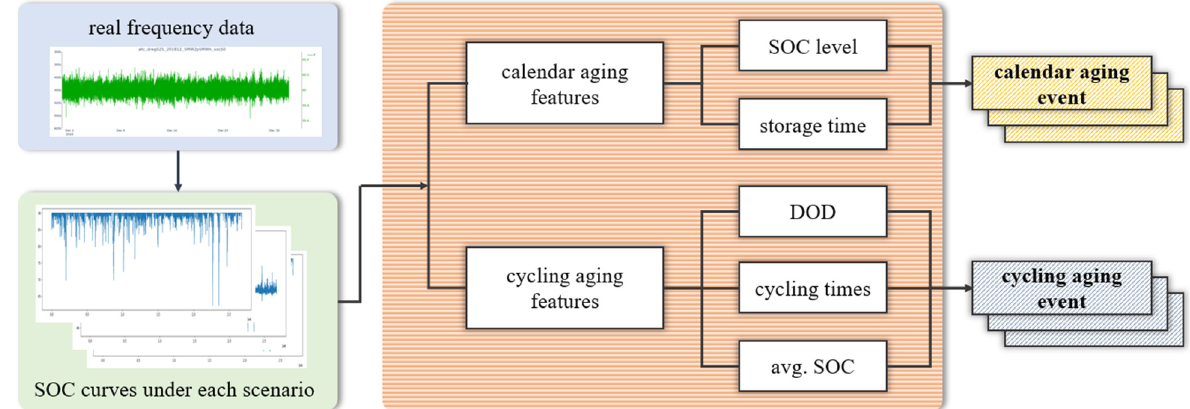
Figure 8. A schematic diagram for aging feature extraction.